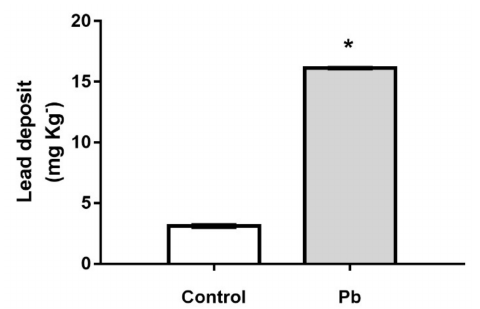
Figure 1. E ff ect of long-term exposure of young Wistar rats to 50 mg / Kg of Pb on lead deposition in cerebellum. The results are expressed as mean ± standard deviation. * Student’s t test, p < 0.0001.